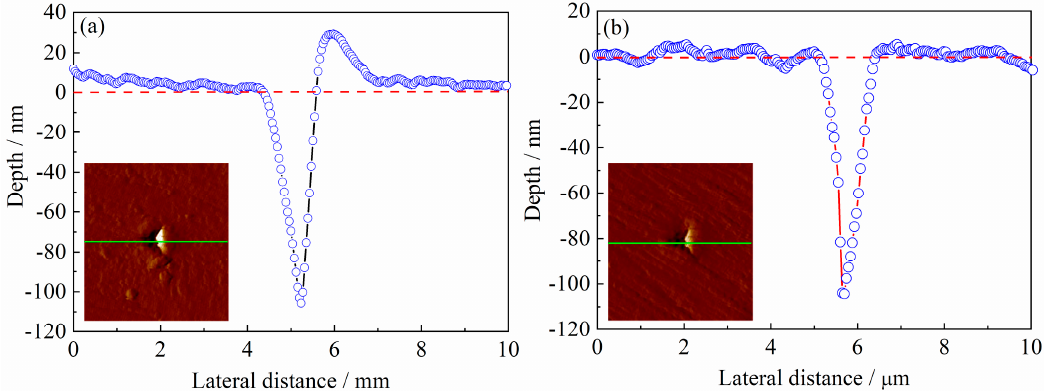
Figure 15. Nanoindentation profiles of tempered 5140 alloy steel before and after proton irradiation: ( a ) unirradiated, ( b ) after irradiation.